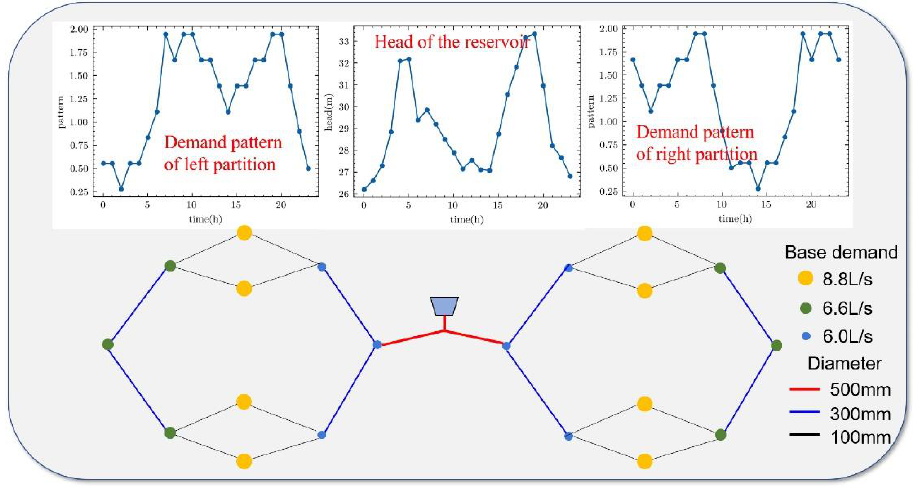
Figure 4. The experimental model.